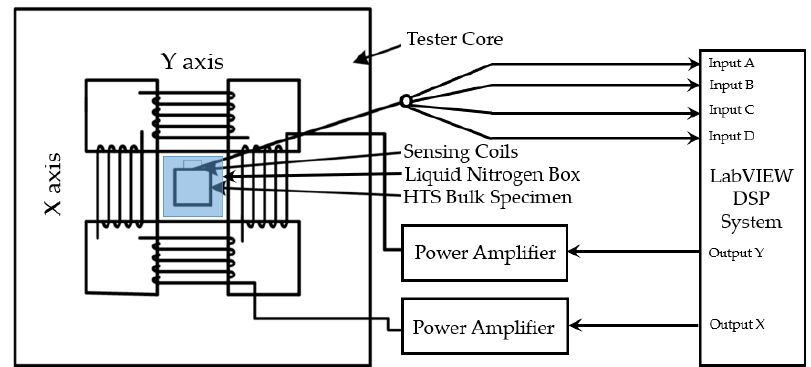
Figure 2. Block diagram of the SST and associated experimental setup.